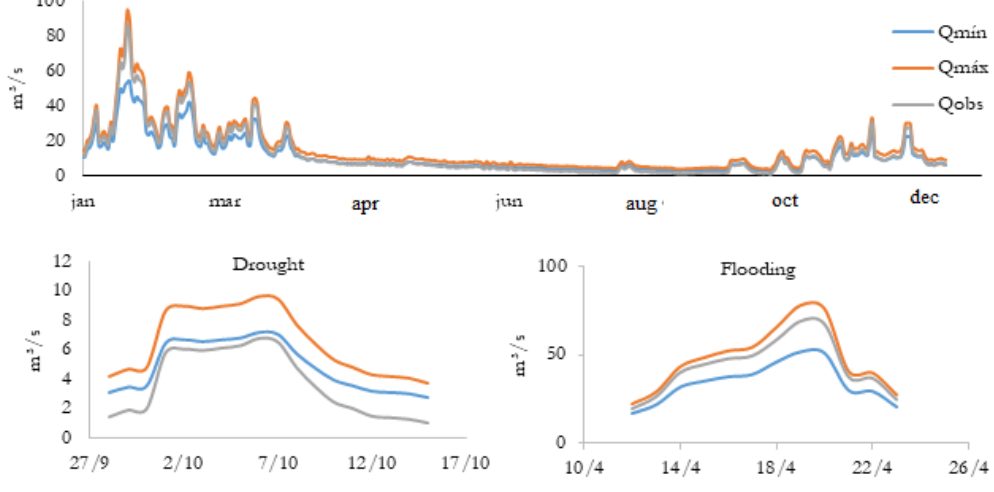
Figure 8. Annual discharge of 2016—GLUE.